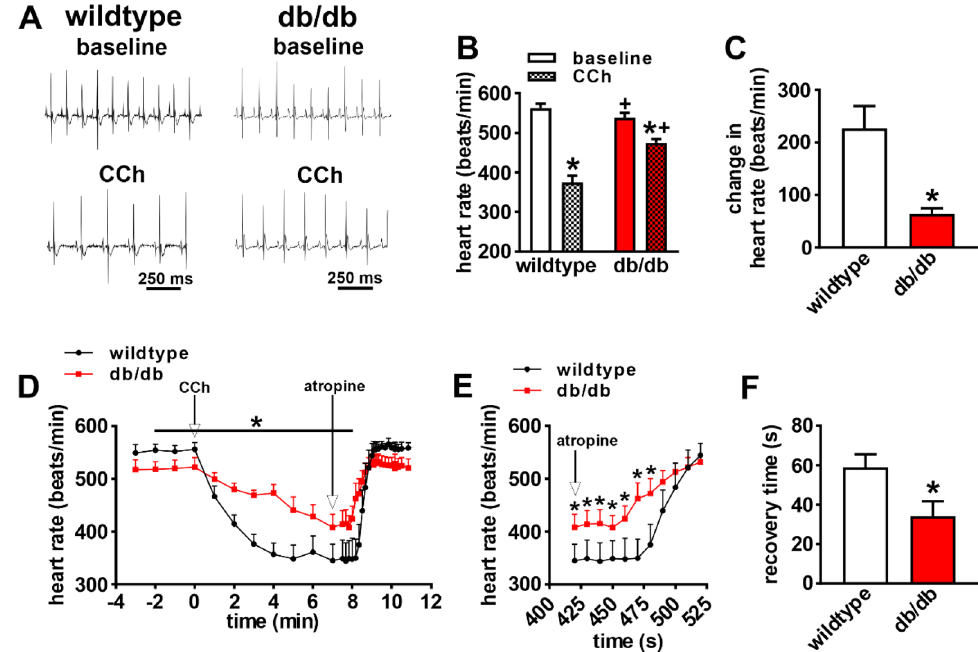
Figure 1. Effects of carbachol on heart rate in db/db mice in vivo. ( A ) Representative surface ECGs in baseline conditions and after application of CCh (0.1 mg/kg) in anesthetized wildtype and db/db mice. ( B ) Summary of heart rate at baseline and after CCh in wildtype ( n = 9) and db/db ( n = 13) mice. * P < 0.05 vs baseline; + P < 0.05 vs. wildtype by two-way ANOVA with Holm–Sidak posthoc test. ( C ) Change in heart rate after CCh application in wildtype and db/db mice. * P < 0.05 vs. wildtype by Student’s t-test. ( D ) Time course of changes in heart rate after application of CCh and atropine (10 mg/kg) in wildtype ( n = 5) and db/db ( n = 6) mice. ( E ) Magnified region of data from panel D illustrating the changes in heart rate upon application of atropine in wildtype and db/db mice. For panels ( D ) and ( E ) * P < 0.05 vs. wildtype by two-way repeated measures ANOVA with Holm–Sidak posthoc test. ( F ) Recovery time for heart rate after application of atropine. * P < 0.05 vs. wildtype by Student’s t